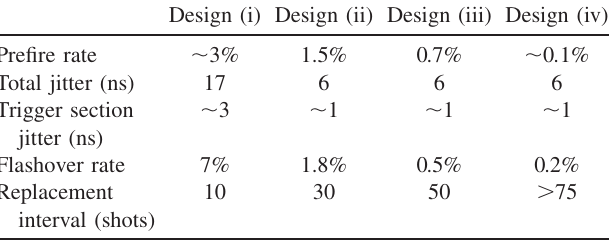
TABLE II. Summary of performance improvements due to design changes when increasing the LTGS operating level from 5.4-MV, 0.7-MA to 6.1-MV, 0.79-MA. The columns rep- resent design iterations and are numbered from left to right as follows: (i) the initially deployed switch on Z after the refurbish- ment [9], (ii) segmenting the cascade insulator of the switch in column (i) with five equally spaced segments and improving laser alignment in the triggered gap [12], (iii) implementing solid acrylic cascade spacers, scalloping the insulator interior surface, implementing Elkonite 50W3 trigger section electrodes, and a monomer-cast trigger section insulator; and (iv) implementing the fast purge and increasing the mechanical integrity of the cascade section. Column (iv) represents present performance of the LTGS on Z